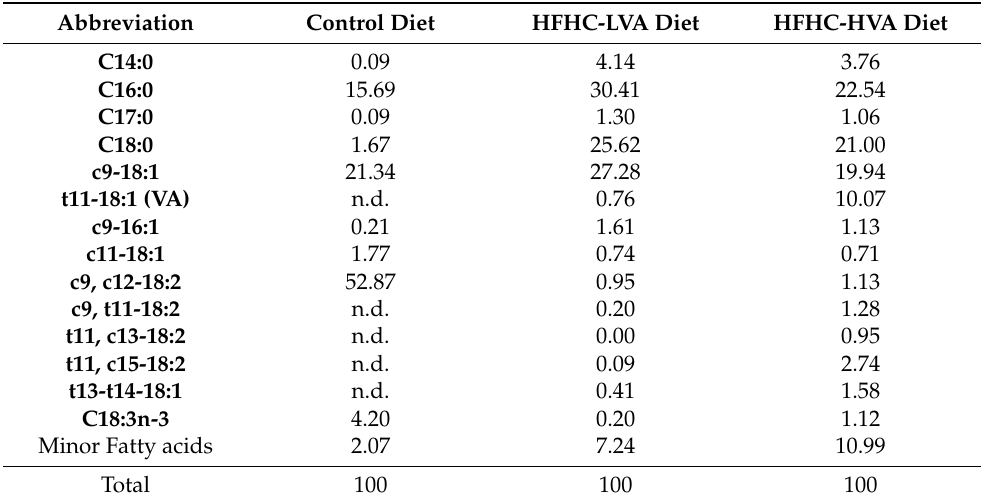
Table 2. Fatty acid profiles for major fats in Control and HFHC phase 3 diets using composition of fatty acid methyl esters